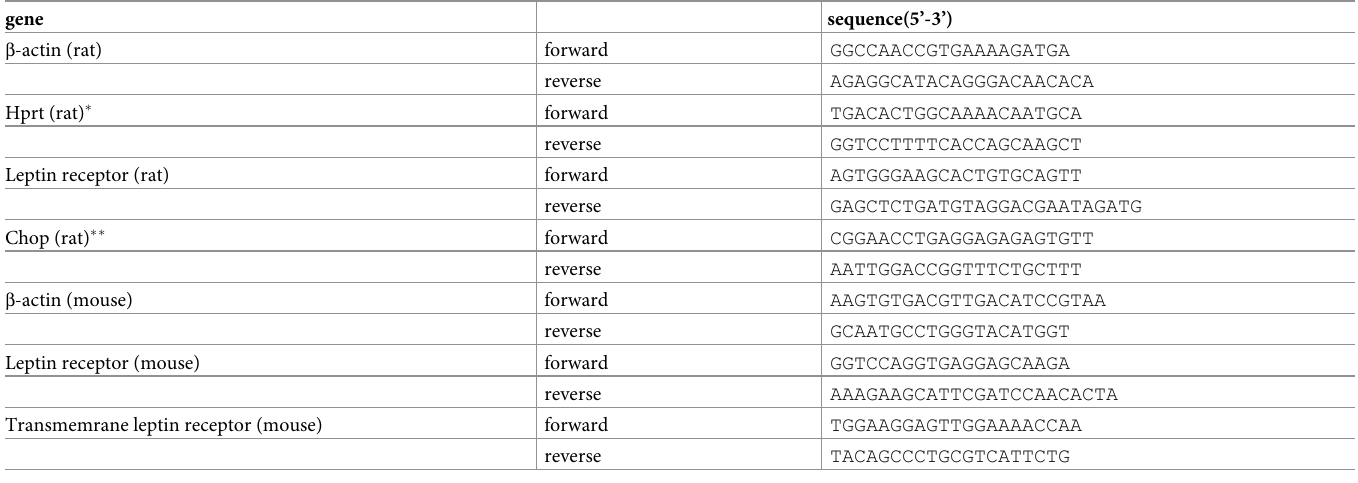
Table 3. Primers for realtime